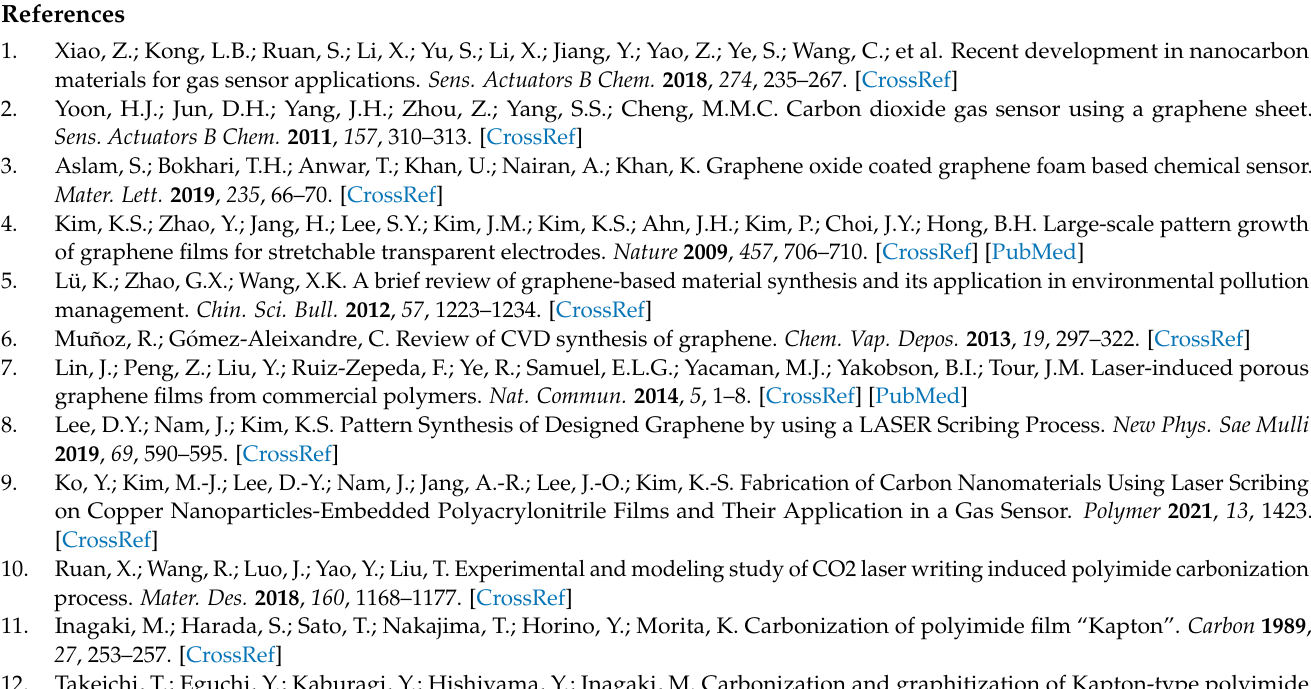
Figure S2: Schematic diagram of as sensing system, Figure S3: Optical images of pulsed-laser scribed spots onto the copper foil with the (a) different scan rate and (b) schematic of spot distance, Figure S4: Optical images of (a) pristine Cu@PI, (b–d) Cu@LSC after laser scribing with different scan rate, and (e) LSC without copper, Figure S5: Photographs of Cu@LSC (a) before and (b) after peel off the untreated layer by dipping in ammonia water, Table S1: Specific parameters of laser scriber (MFP-20), Table S2: Specific synthesis conditions of the Cu@LSC with different spin-coating condition, scan rate and laser